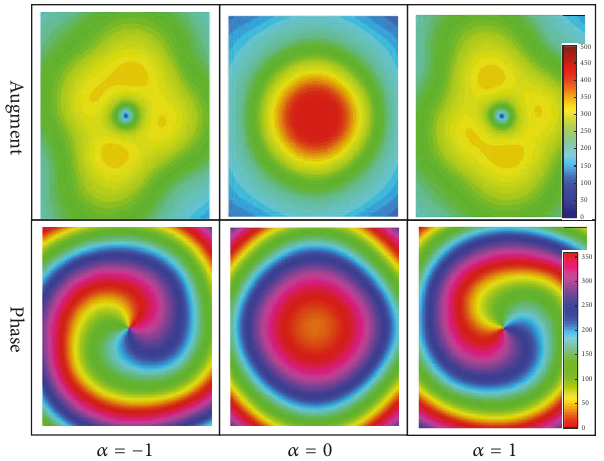
Figure 9: Augments and phases of vortex waves with different topological index of modal-1, modal 0, and modal 1(a=14.8mm).